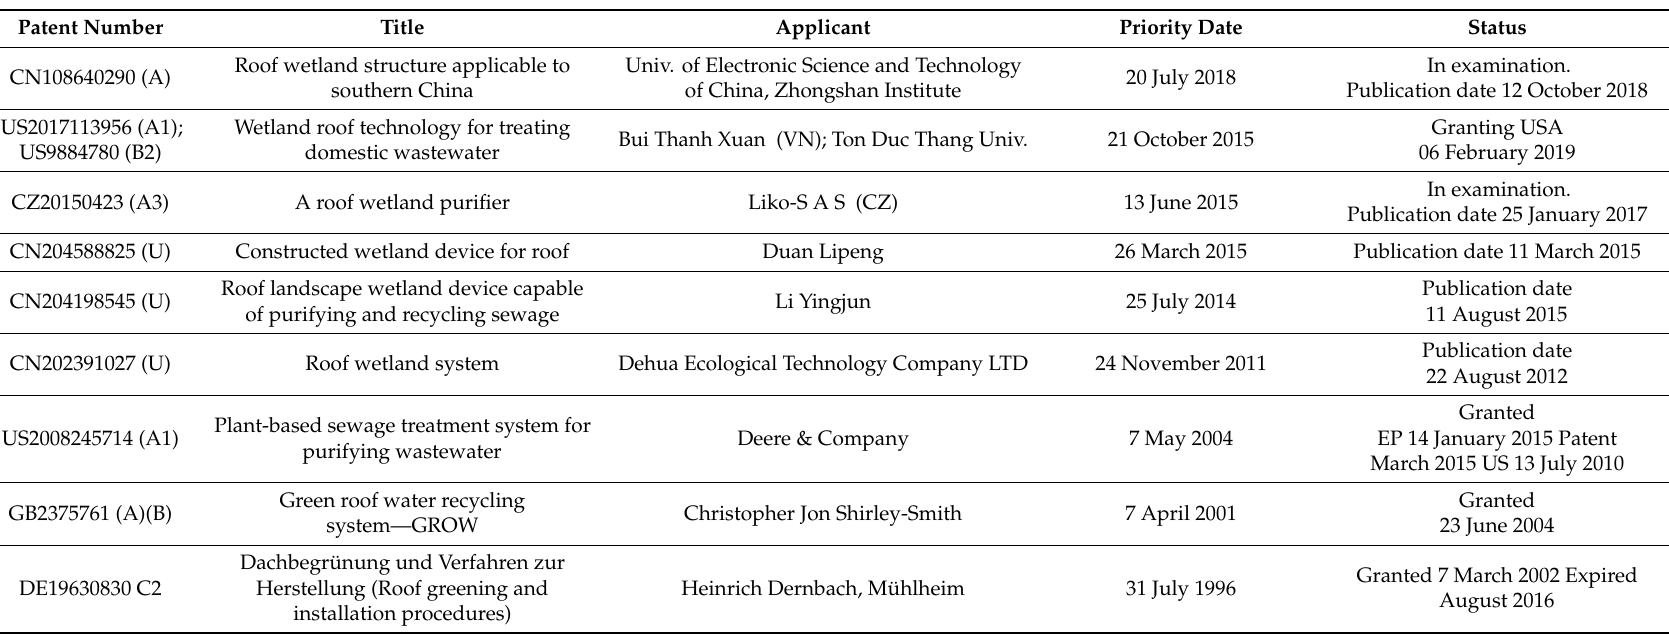
Table 1. Patents on wetland roofs (search with “Orbit Intelligence—Questel”, date 19 February